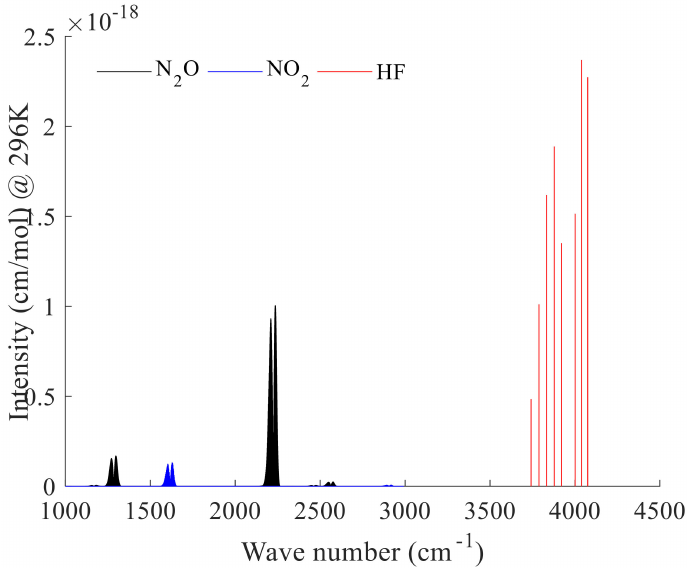
Figure 1. N 2 O, NO 2 , and HF line intensities and distributions.